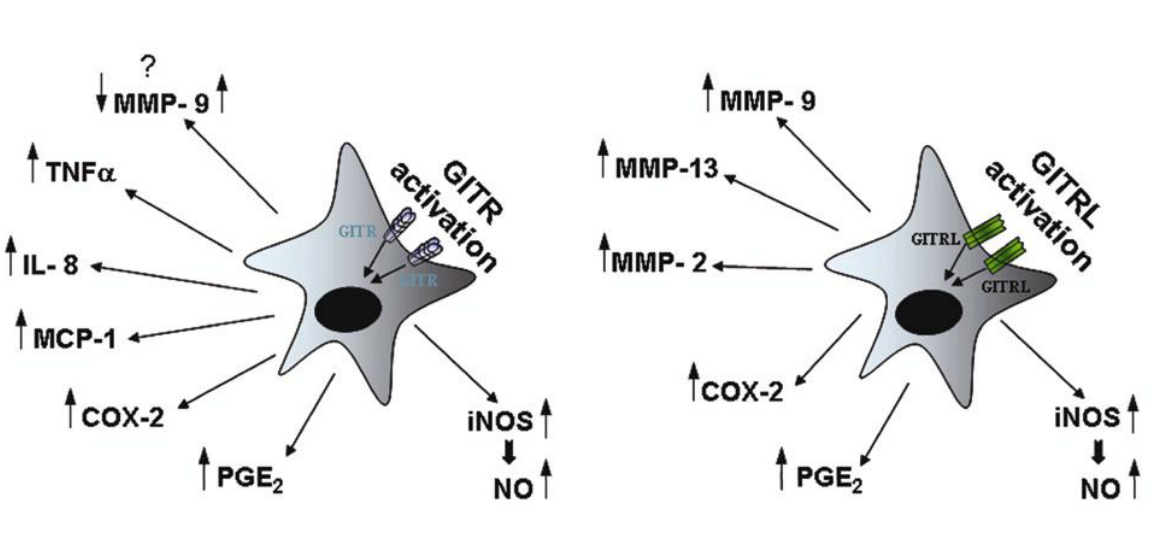
FIGURE 2. Potential effects of GITR and GITRL triggering on